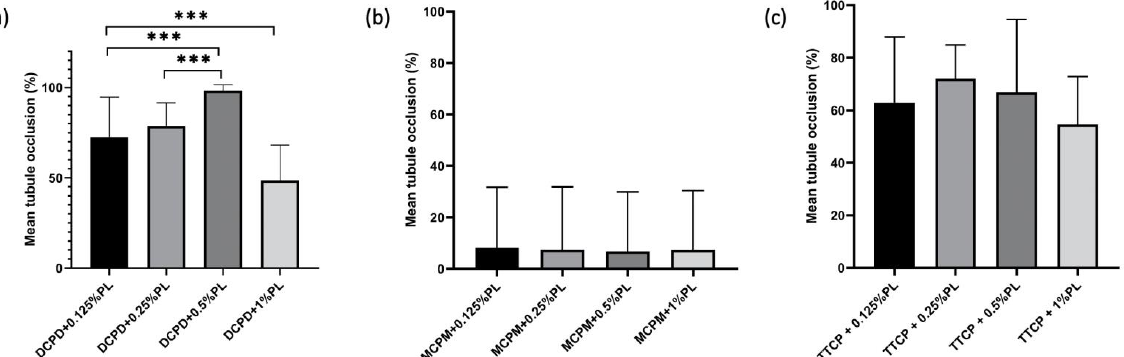
Figure 6. Dentin tubule occlusion rate in three groups after CPP and ε -PL application. ( n = 10). ( a ) occlusion rate of DCPD groups on P. g -infected dentin specimens ( b ) occlusion rate of MCPM groups on P. g -infected dentin specimens ( c ) occlusion rate of TTCP groups on P. g -infected dentin specimens. *** p < 0.001.